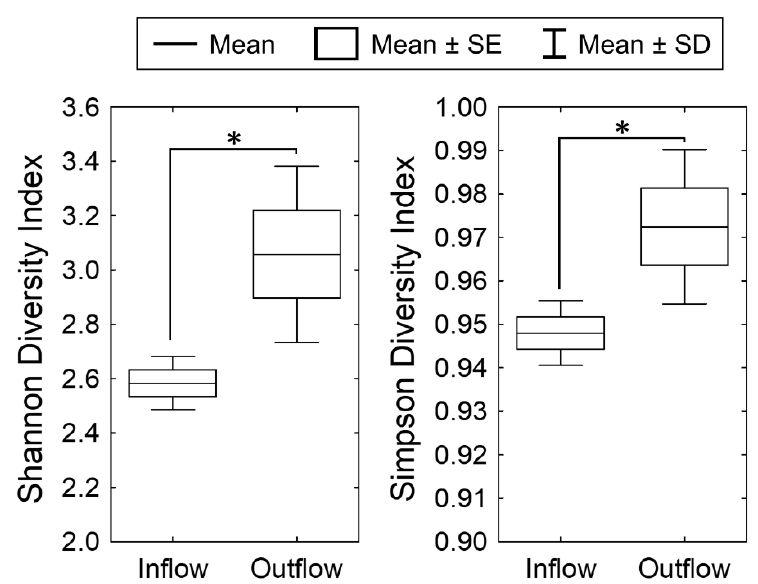
Figure 4. Shannon and Simpson diversity indexes of the periphyton at the inflow and outflow of the ecologically engineered Grootspruit wetland. The statistical analysis was performed with the drought year (2016) included and excluded. The asterisks indicate noteworthy statistical differences, p < 0.05. Table 3. Average chemical and physical parameters measured during the sampling period of 2015– 2018 at the inflow and outflow of the wetland ( n =